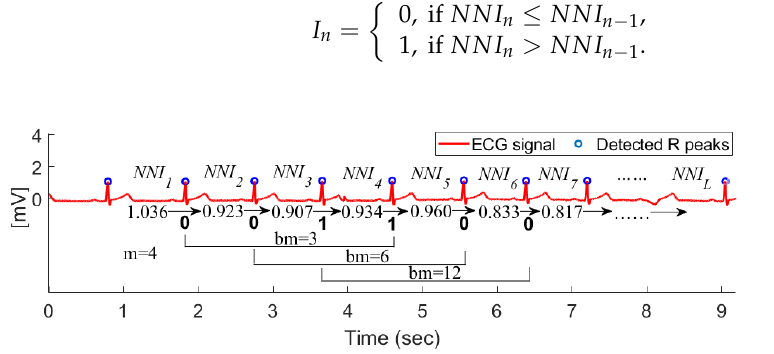
Figure 3. Schematic diagram of the mapping process from the ECG signal to a 4-bit